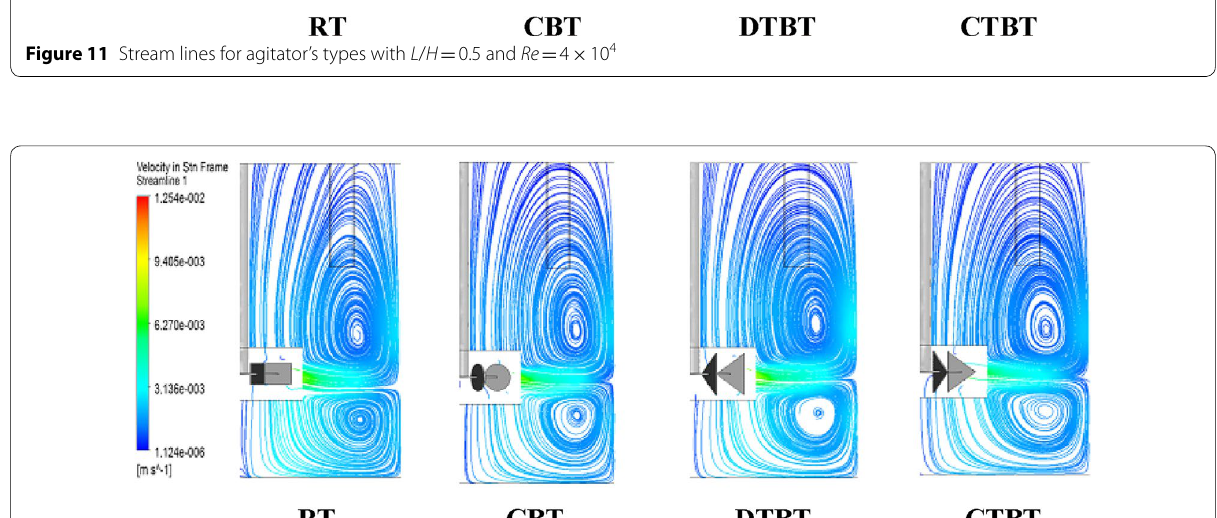
Figure 12 Stream lines for agitator’s types with L / H